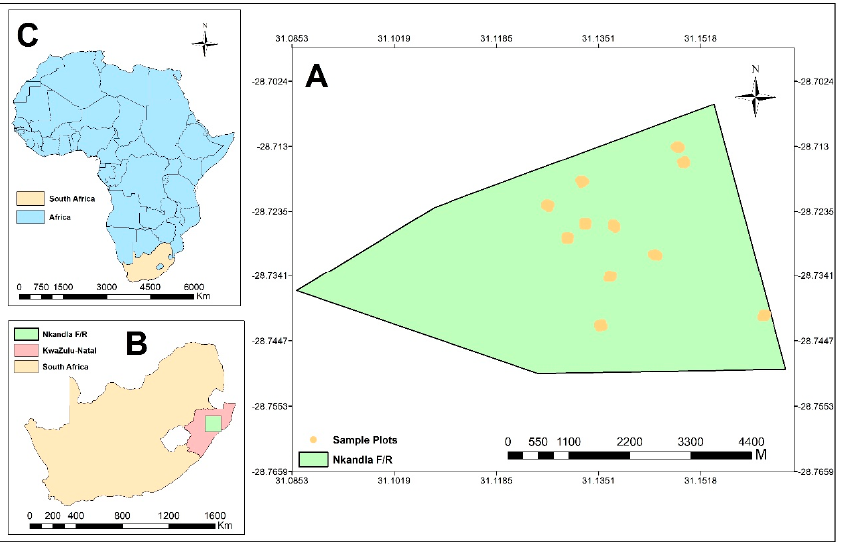
Figure 1. Map of the study area. Note: A is the Nkandla forest reserve, B is the map of South Africa indicating the location of KZN province and the forest and C is the map of Africa indicating the location of South Africa.